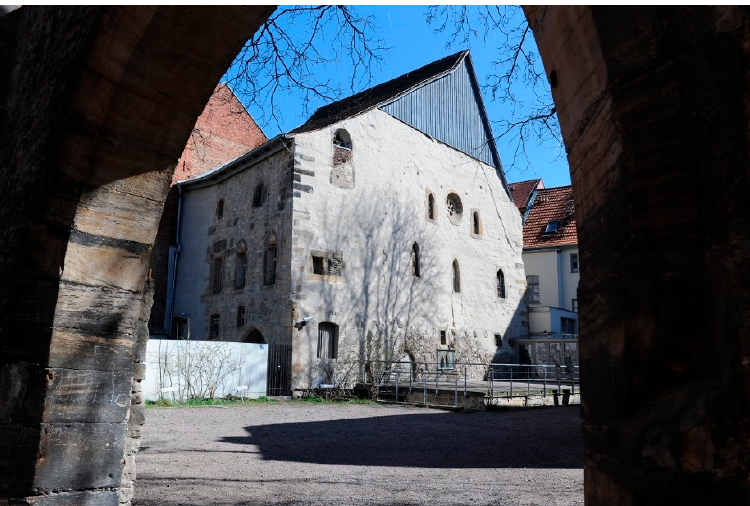
Figure 1. Medieval Synagogue of Erfurt, Western Façade (Albrecht von Kirchbach, used with permission).